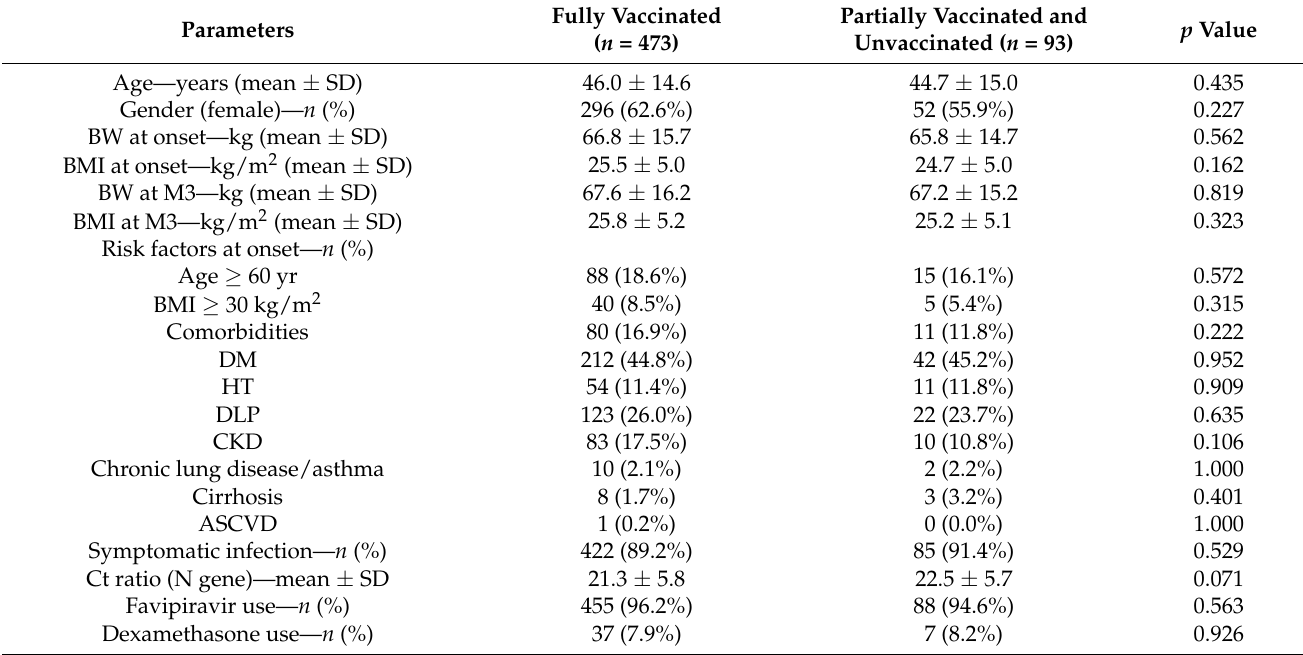
Table 2. Baseline demographic data of immunocompetent patients classified by vaccination status at 3 months postinfection; n =